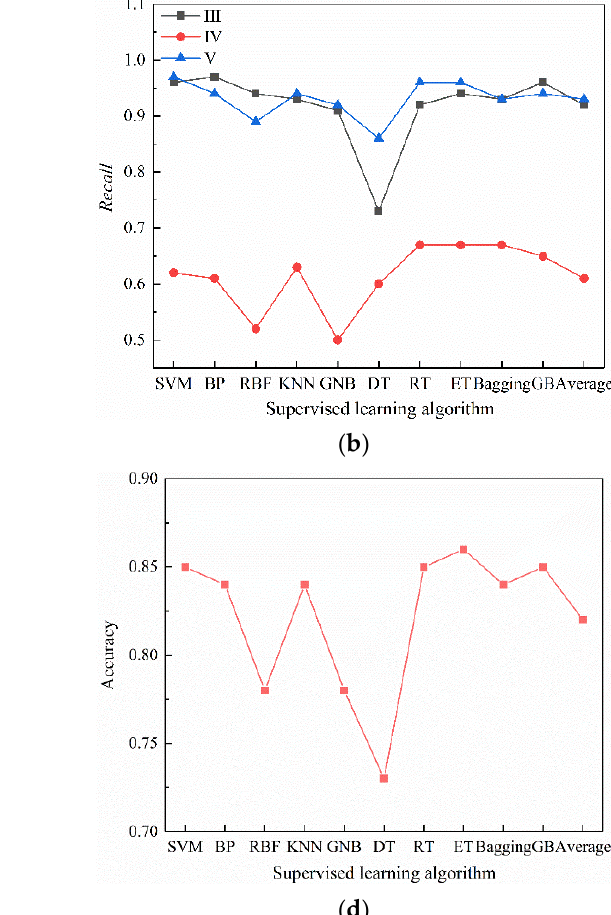
Figure 8. Model parameter optimization and evaluation process.